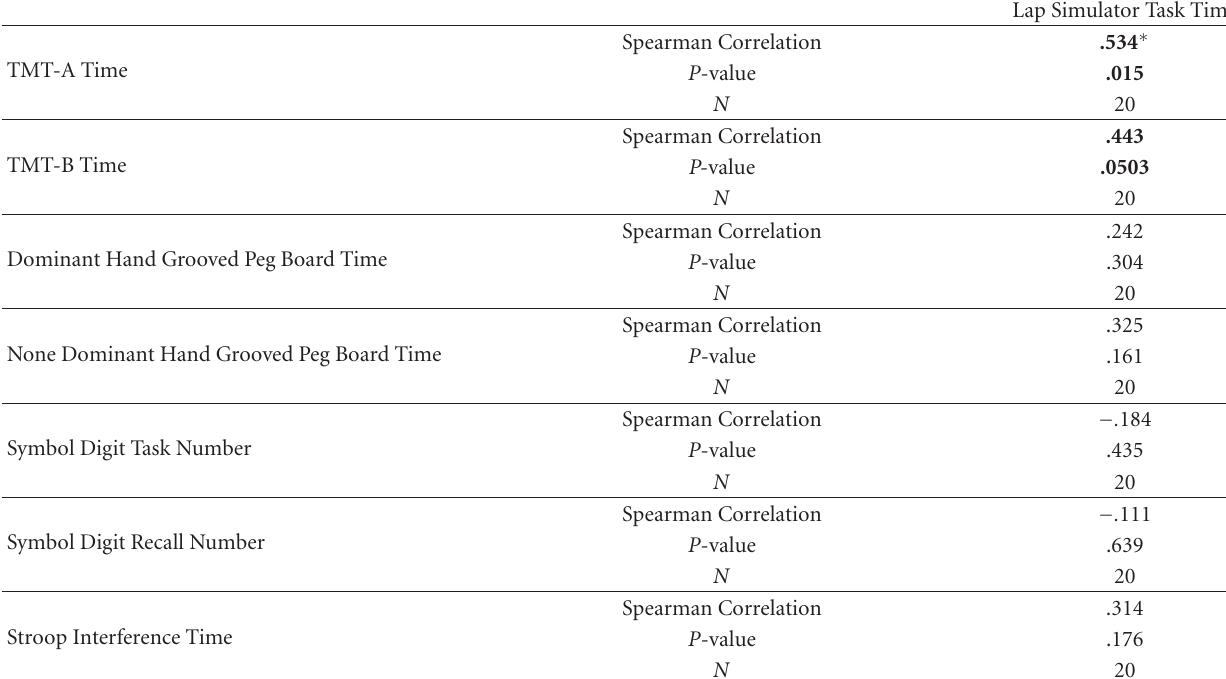
Table 3: The relationship between neurocognitive tests and laparoscopic simulator